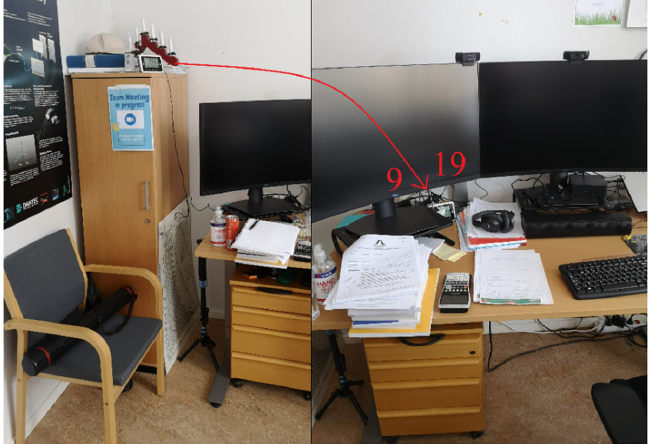
Figure 11. First and second placement of loggers 9 and 19 in Room C.